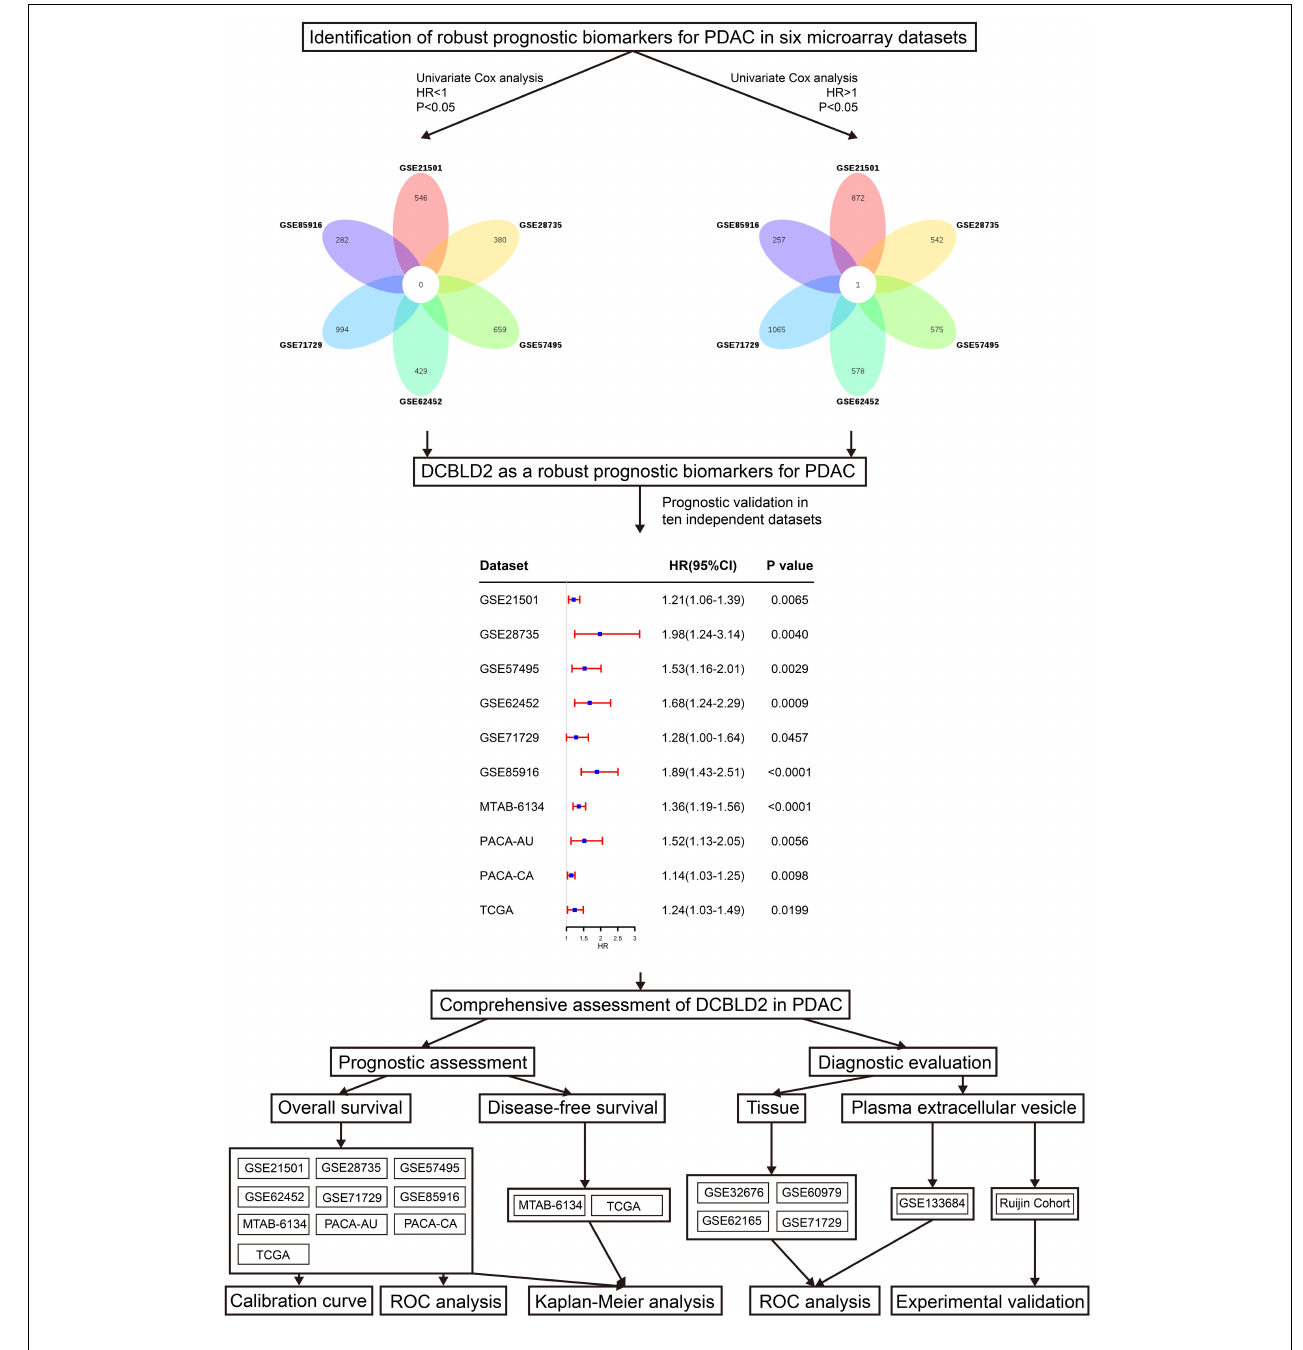
FIGURE 1 | Overall flowchart study design and data analyses of this